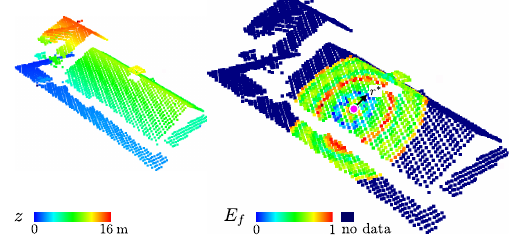
Figure 3: Illustration of the relevance of the entropy feature for scale selection (building roof in ALS G ). Left : 3D point cloud (height colored). Right : 3D point cloud colored with E f com- puted for one point of interest (pink dot). The color of each neigh- bor P k corresponds to the E f value, computed on the smallest neighborhood containing P k . The entropy first decreases until the neighborhood reaches the edge of the roof (blue circle – op- timal size). Then, the entropy increases and becomes maximum when the neighborhood gathers distinct objects (red circle), here the ground and a